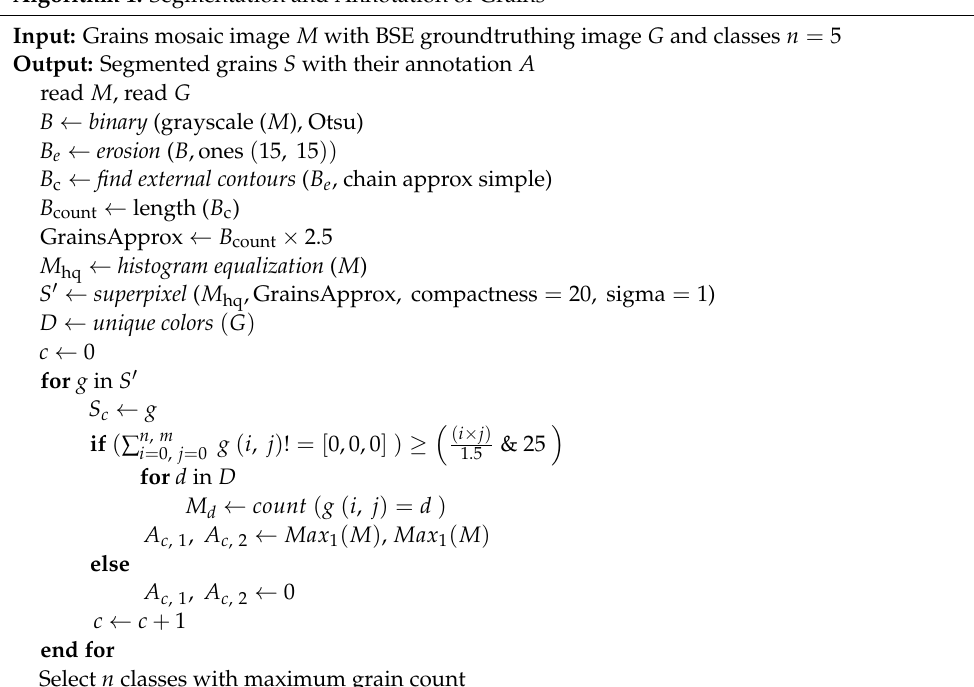
Algorithm 1: Segmentation and Annotation of Grains